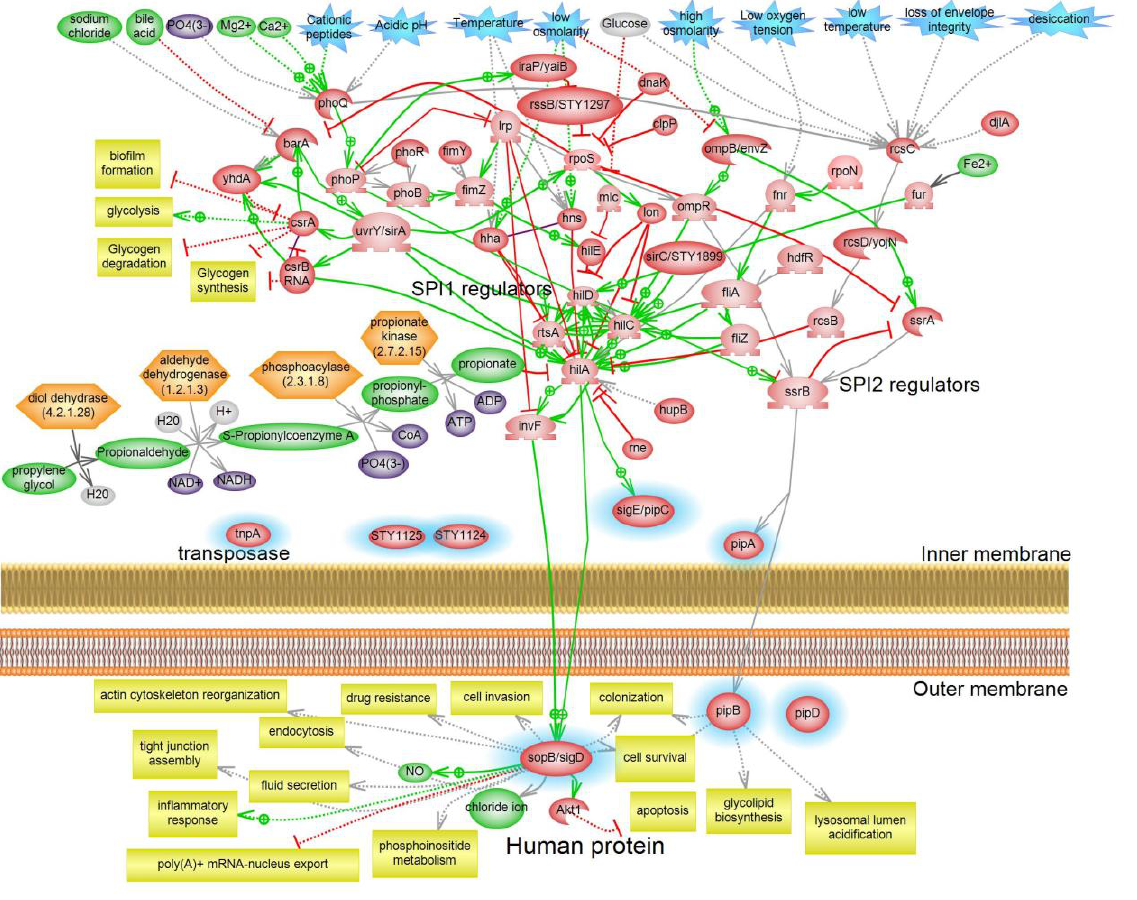
Figure 6: SPI-5 regulation pathway. SigD/SopB, PipA, and PipB contribute to enteropathogenesis, which triggers fluid secretion responsible for diarrhea. Proteins encoded by SPI-5 are highlighted in blue. A detailed view of the SPI-5 pathway including supporting literature is available at